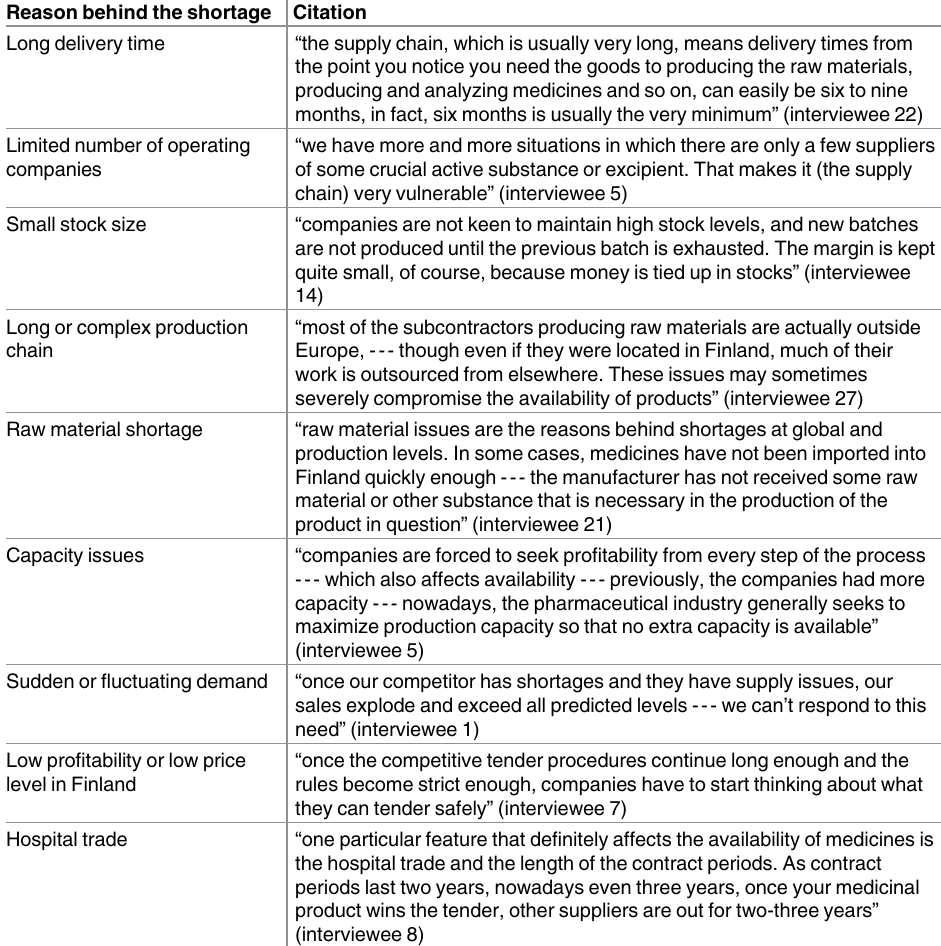
Table 4. Citations of the interviewees on the most common 1 reasons behind medicine shortages in this